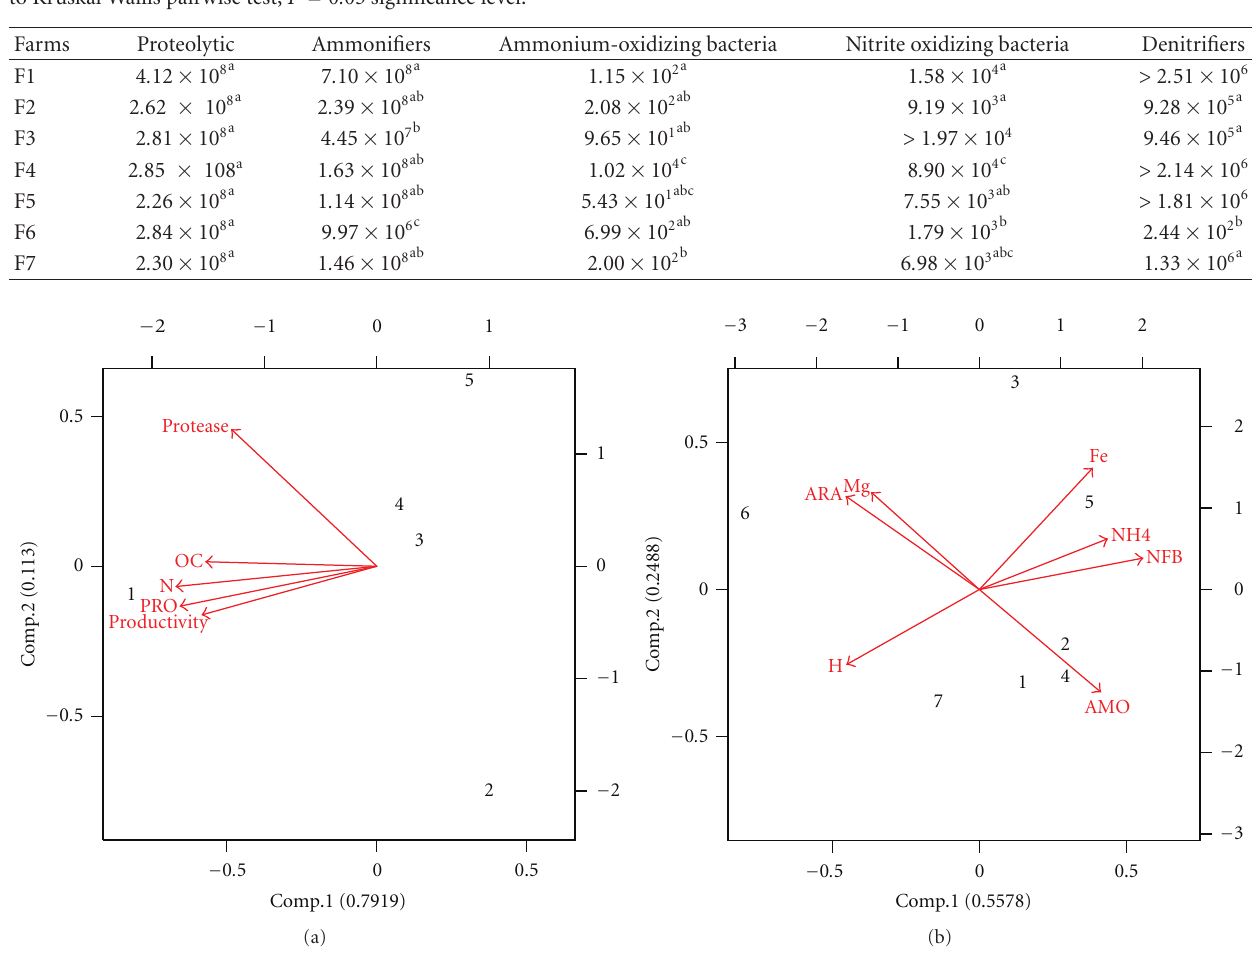
Table 2: Most probable number for some functional groups associated with the edaphic metabolism of nitrogen. The average of three values is shown for every functional group, expressed as mpn g − 1 dry soil. Values having the same letter were not significantly di ff erent according to Kruskal Wallis pairwise test, P = 0 . 05 significance level.